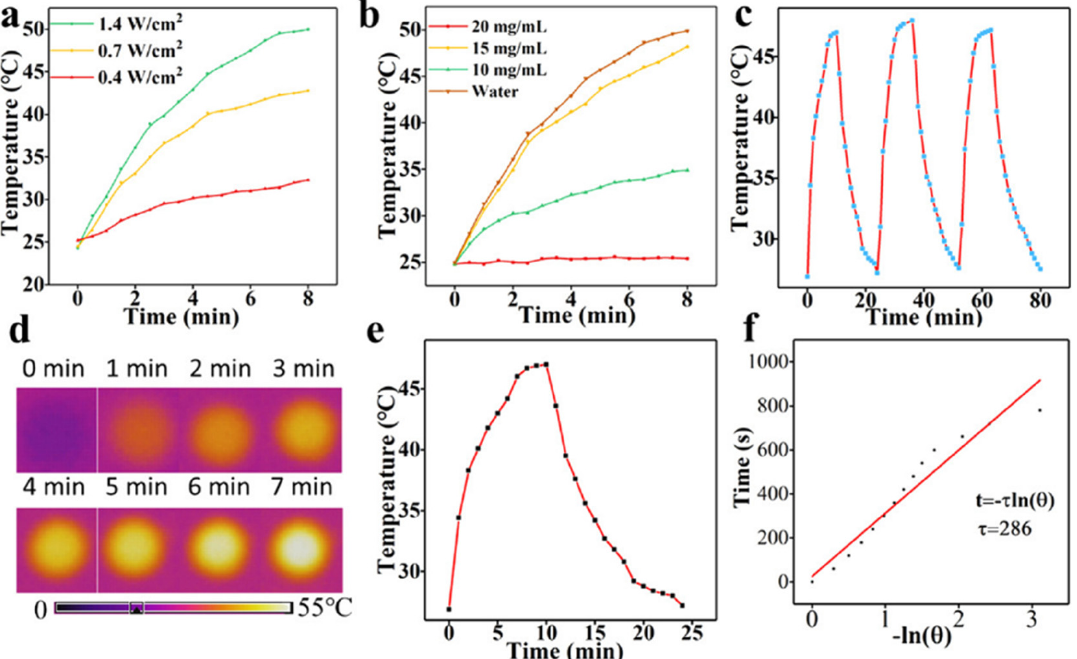
Figure 14. ( a ) Temperature curves of C-DOTs solution (20 mg/mL); ( b ) Temperature curves of different concentrations of C-DOTs solutions *; ( c ) Photothermal profiles of C-DOTs solution ** with 3 irradiation cycles *; ( d ) Thermal infrared im- different concentrations of C-DOTs solutions; ( c ) Photothermal profiles of C-DOTs solution with ages of C-DOTs solutions ** recorded after 7 min of irradiation *; ( e ) Heating and cooling curves of C-DOTs solution *,**; 3 irradiation cycles; ( d ) Thermal infrared images of C-DOTs solutions recorded after 7 min of irradia- ( f ) Linear time data and − ln θ acquired from a cooling period of ( e ). * 1.4 W cm − 2 ; ** 15 mg/mL. Reproduced from Ref. [121] tion ; ( e ) Heating and cooling curves of C-DOTs solution; ( f ) Linear time data and − ln θ acquired from with permission from ACS. a cooling period of ( e ). 1.4 W cm − 2 ; 15 mg/mL. Reproduced from Ref. [121]. Copyright 2019